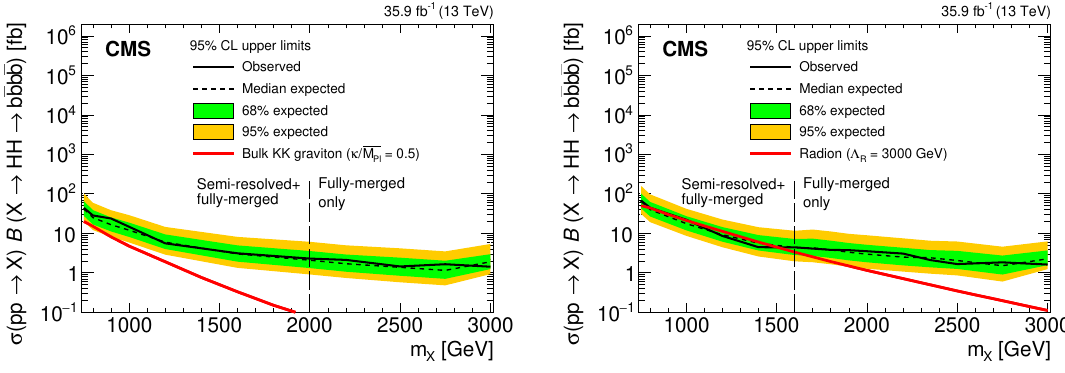
Figure 5 . The upper limits for a bulk graviton (left) and radion (right), combining the fully-merged and the semi-resolved analysis (where the events used in the fully-merged analysis are not considered in the semi-resolved analysis). The inner (green) and the outer (yellow) bands indicate the regions containing the 68 and 95%, respectively, of the distribution of limits expected under the background- only hypothesis. The theoretical predictions are shown as the red lines. Results above 2000 (1600) GeV for the bulk graviton (radion) are taken directly from the fully-merged analysis [39].